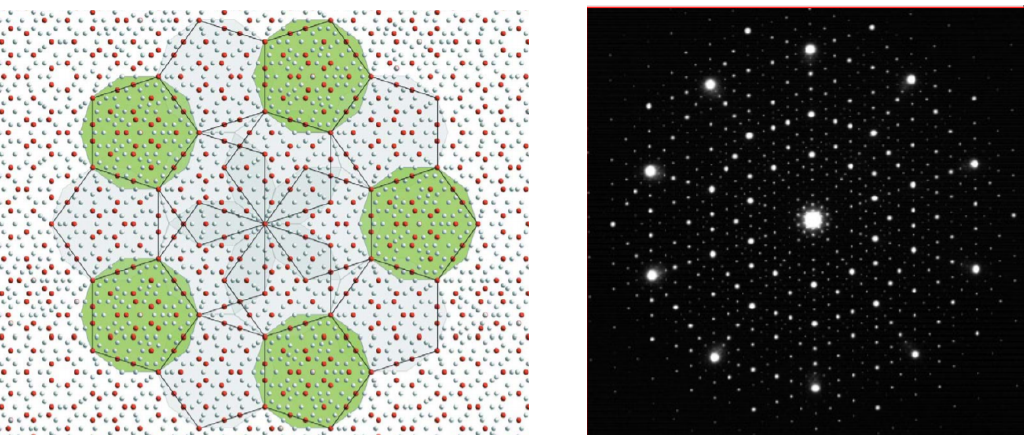
Figure 1: Left: A section perpendicular to the decagonal axis of the Al-Co-Ni qua- sicrystal from [ 48 ] . Right: Electron diffraction pattern from an icosahedral qua- sicrystal. Notice that the intensity distribution of the diffraction pattern varies over many orders of